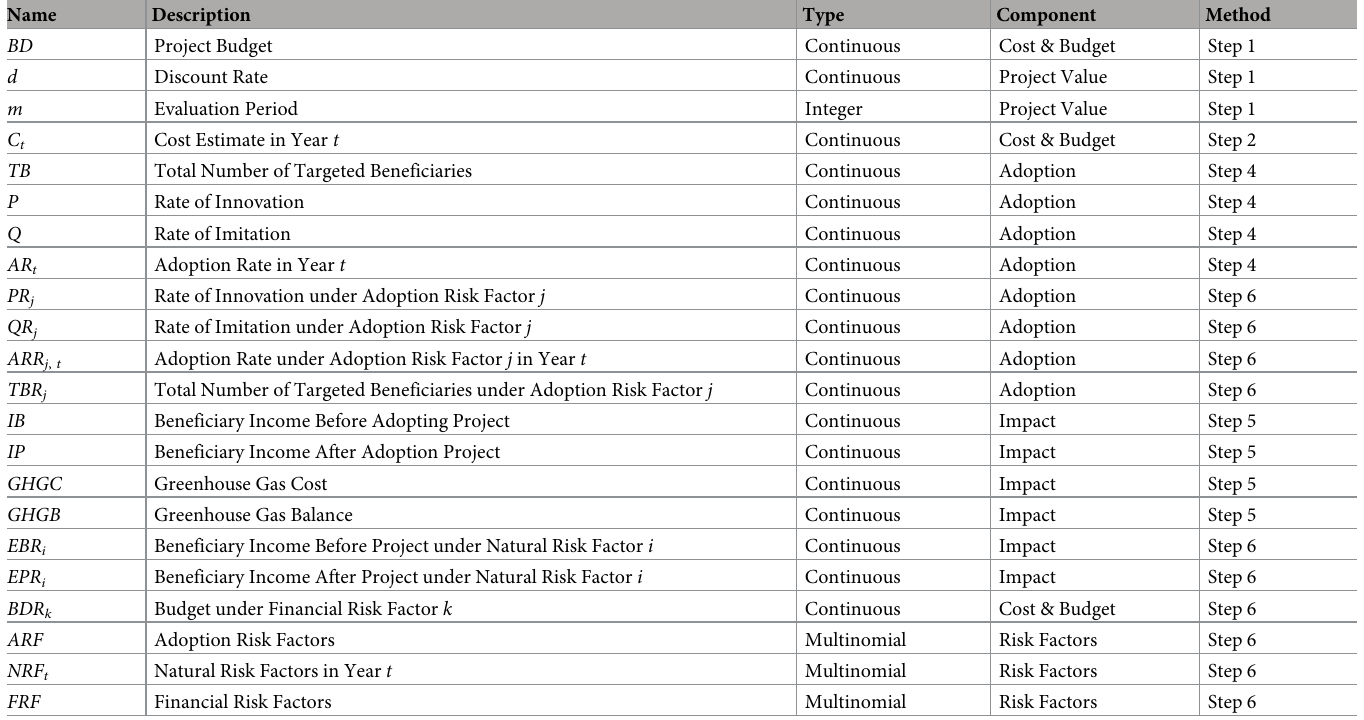
Table 1. Parameters identified in different steps of the proposed